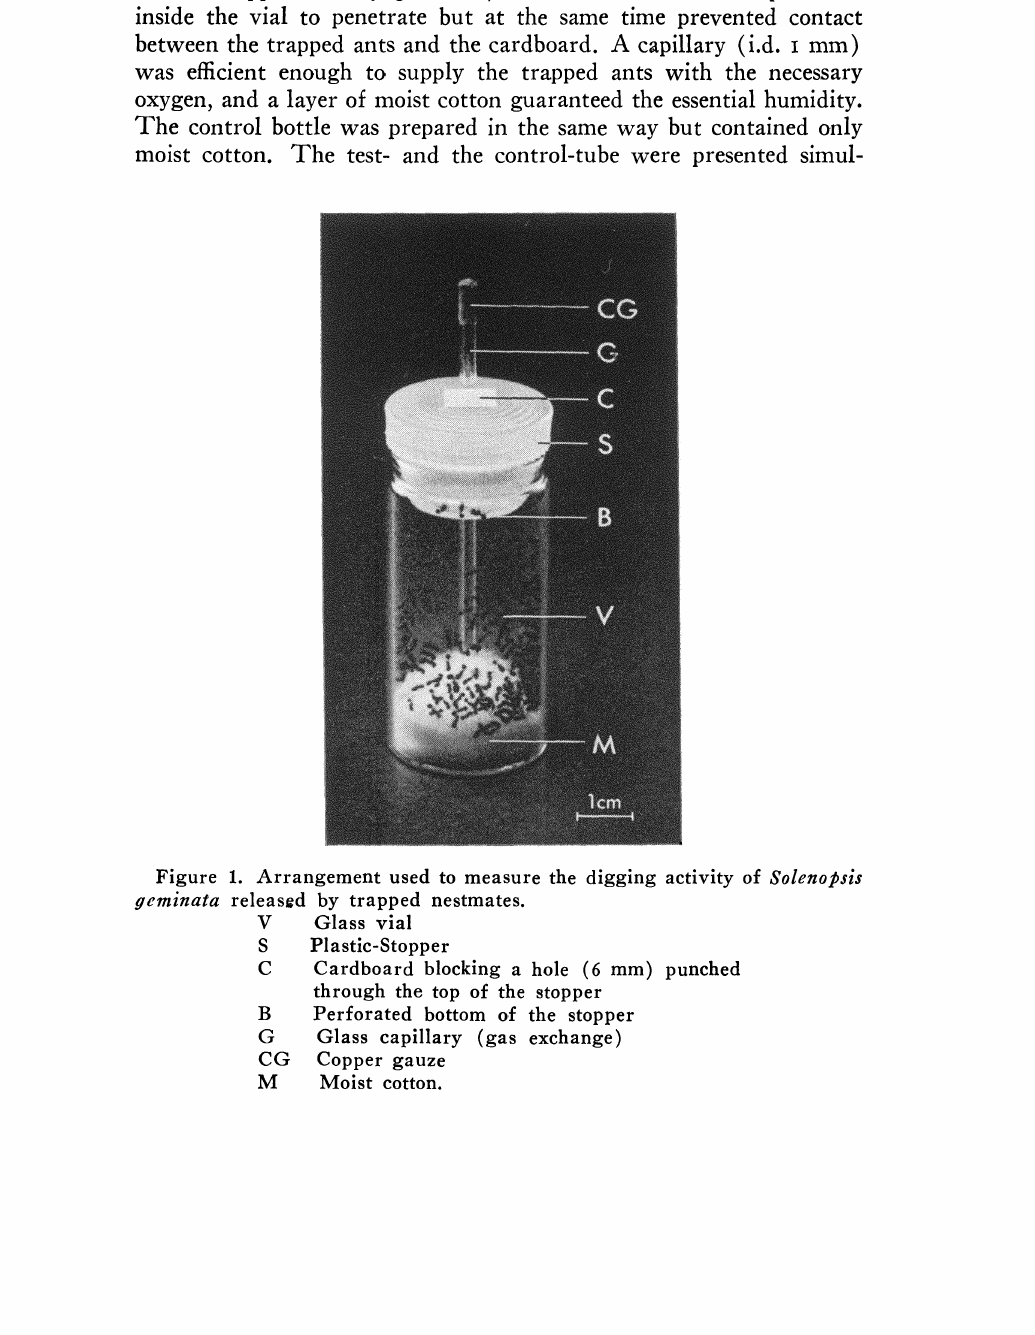
Figure 1. Arrangement used to measure the digging activity of Solenolsis geminata released by trapped nestmates. Glass vial Plastic-Stopper Cardboard blocking a hole (6 mm) punched through the top of the stopper B Perforated bottom o,f the stopper G Glass capillary (gas exchange) Copper gauze CG M Moist